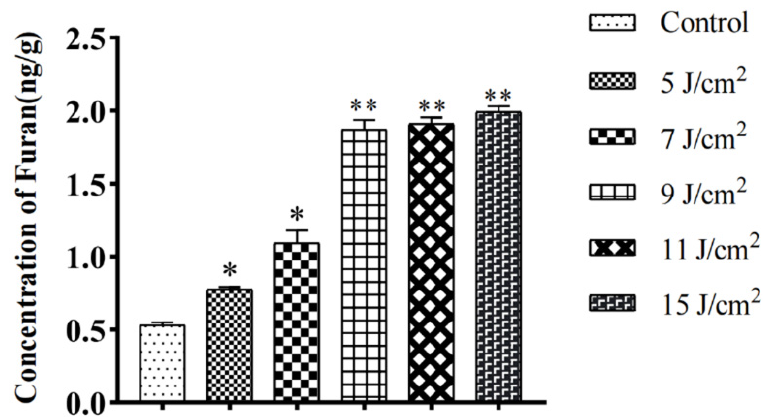
Figure 5. Furan concentration after UV-C treatment of glucose-alanine simulated solution. * means p < 0.05, and ** means p < 0.01.